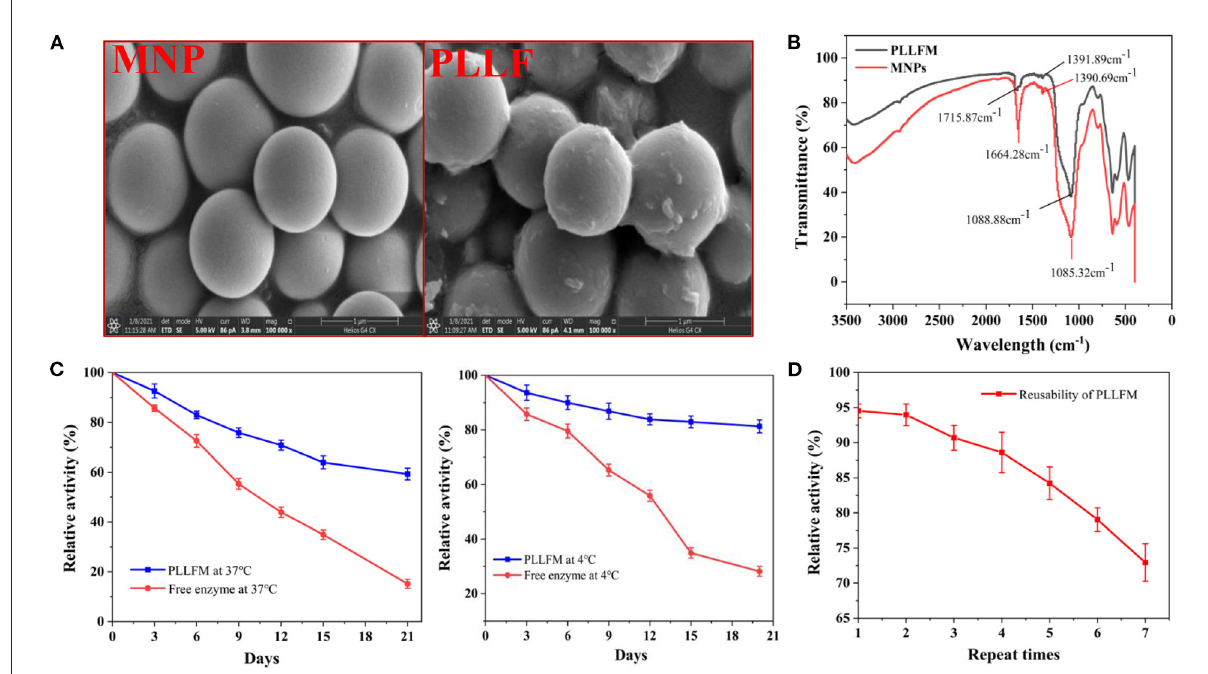
FIGURE1 Characterization and properties of PLLFM. (A) SEM Characterization. (B) FT-IR Characterization. (C) Storage stability. (D) Reusability of